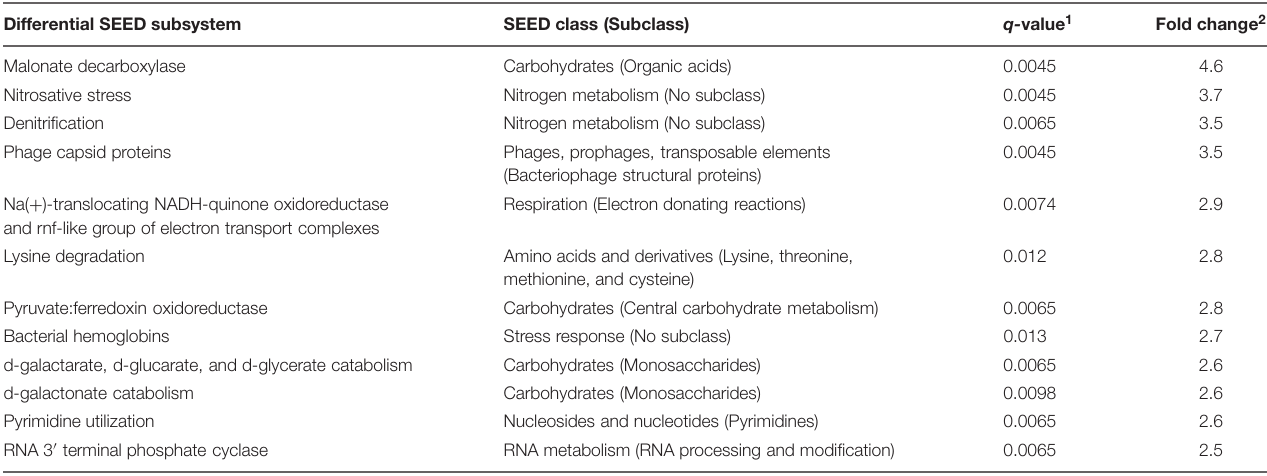
TABLE 4 | Differentially abundant gene functional groups between samples with higher and lower water quality in the agricultural watershed. Differential SEED